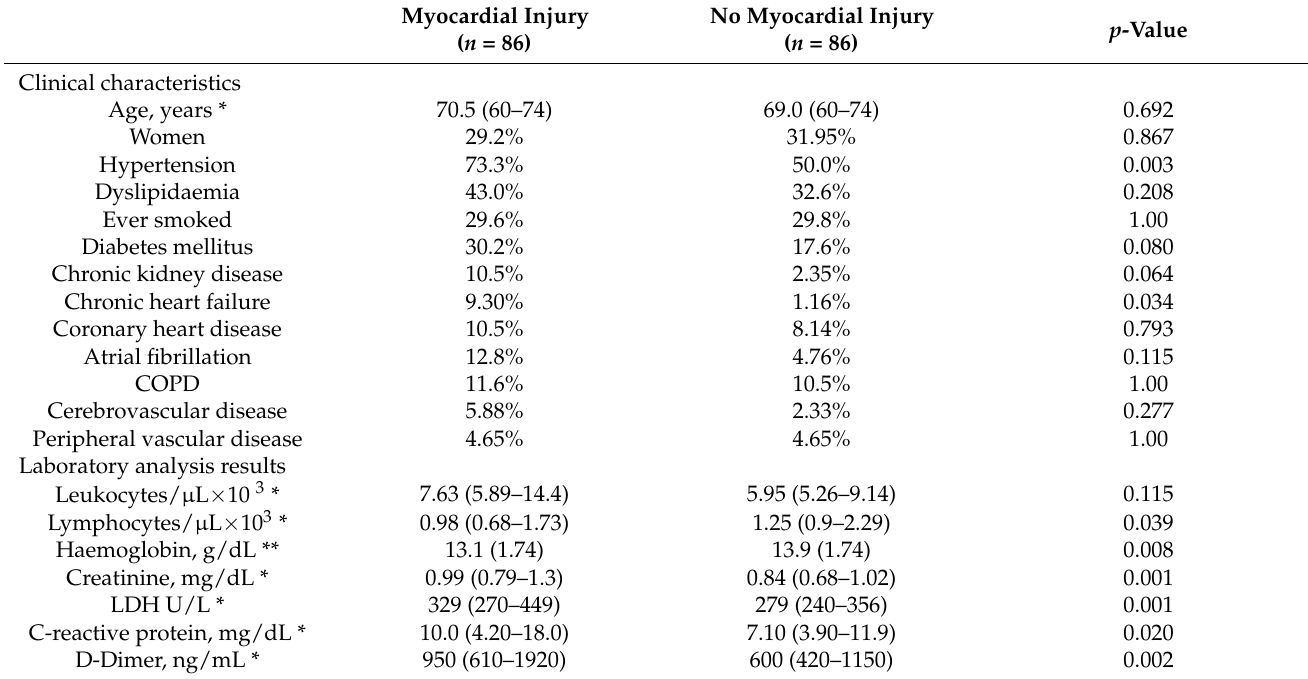
Table 1. Baseline characteristics at hospital admission in COVID-19 patients with and without myocardial injury. Myocardial